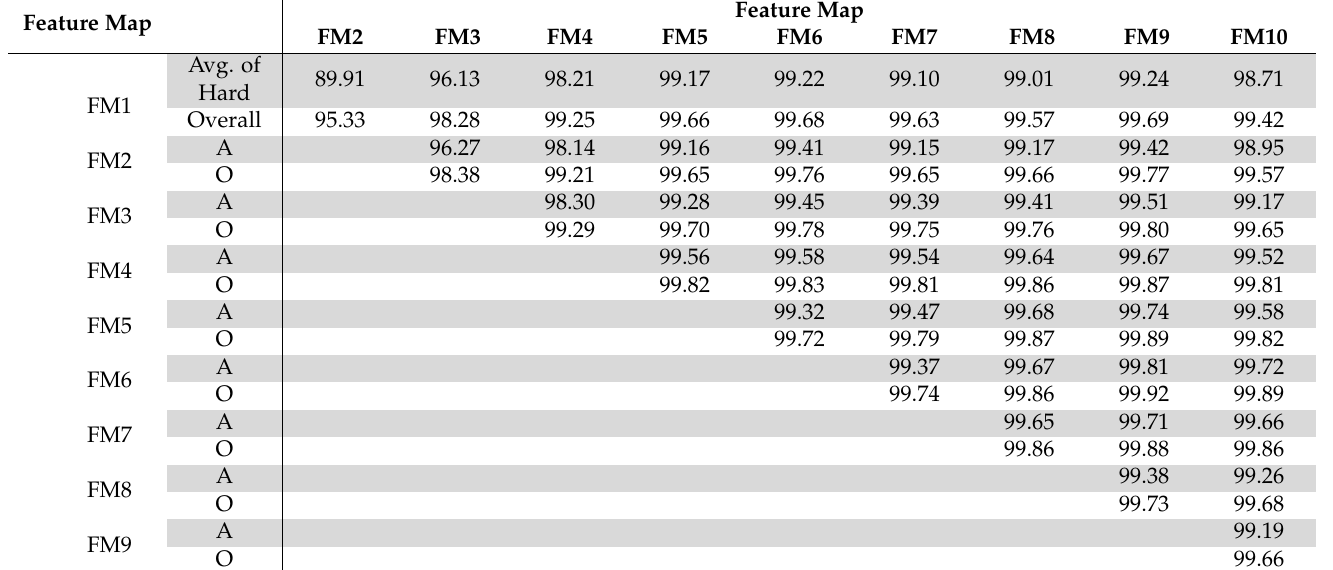
99.86 99.88 99.86 99.38 99.73 99.68 99.19 99.66